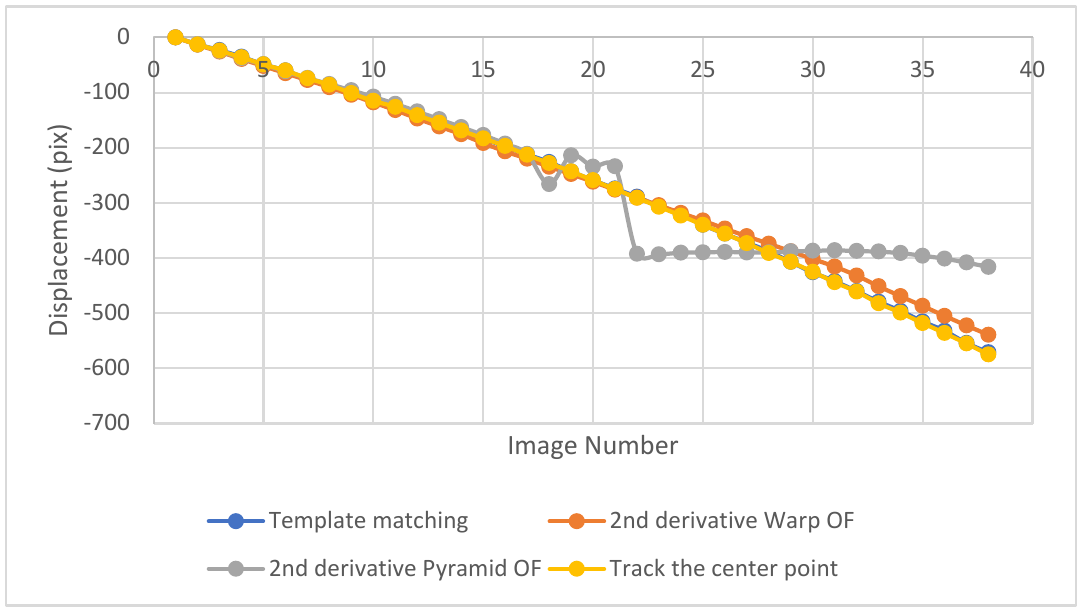
Figure 9. Displacement of a free-falling aggregate obtained using the pyramid and warp Sobel LK optical flow, compared with the displacement obtained using the template matching method.